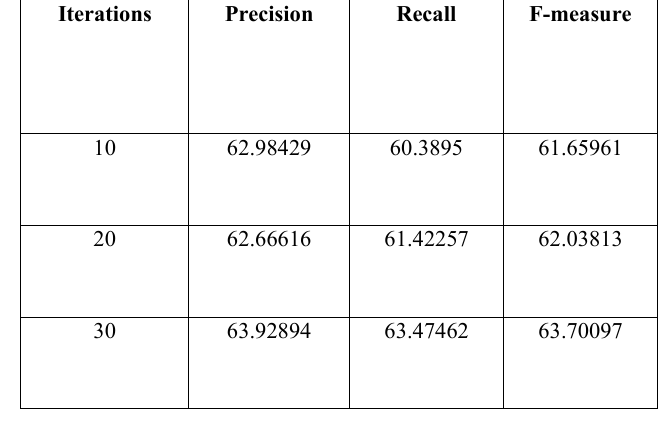
. Table 2. Precision, Recall and F-Measure values for existing ABC